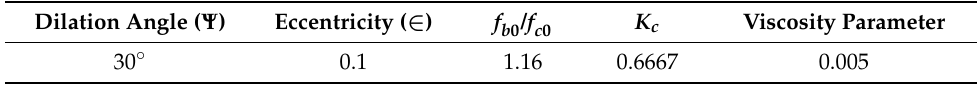
Table 6. The CDP model parameters for concrete. Dilation Angle ( Ψ